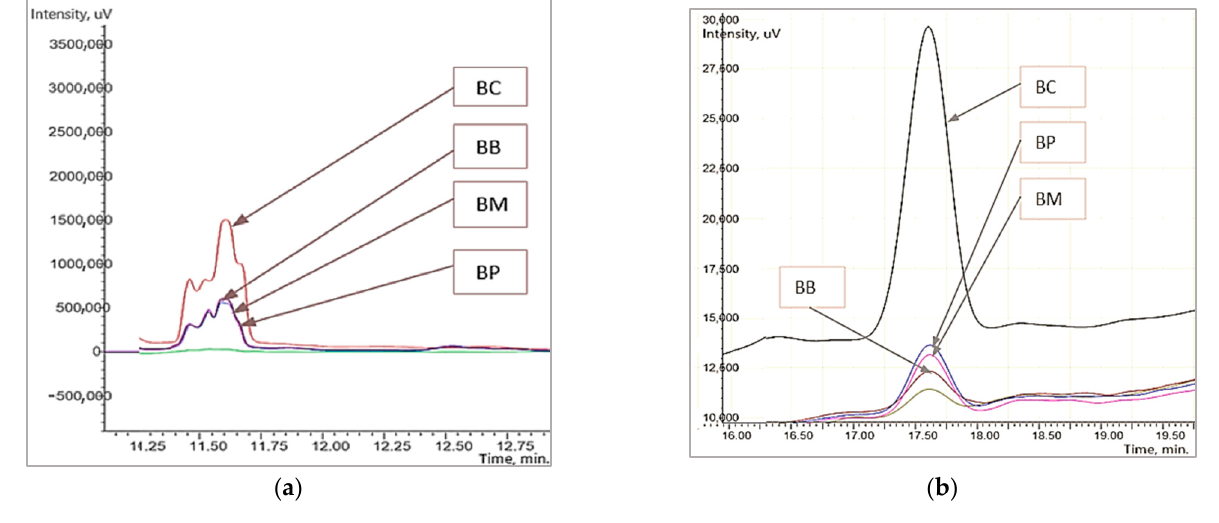
Figure 7. Peak area of HPLC chromatogram of wheat bran samples gliadin extract after incubation of 4 h at 45 °C: ( a ) ω -gliadins; ( b ) α -gliadins (BC, control bran sample; BB, bran treated with bromelain; BP, bran treated with papain, BM, bran treated with a combination of bromelain and papain). α -Gliadins have the highest immunoreactivity; therefore, their changes are most rel-